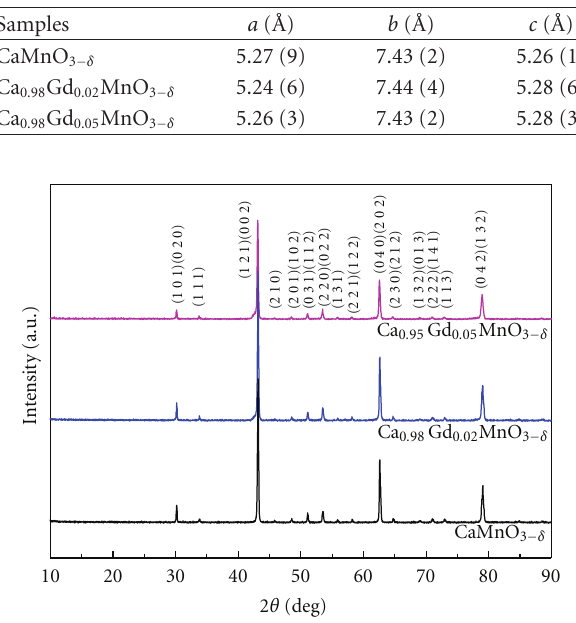
Figure 1: XRD patterns of the Ca 1 − x Gd x MnO 3 − δ (0.00, 0.02, and